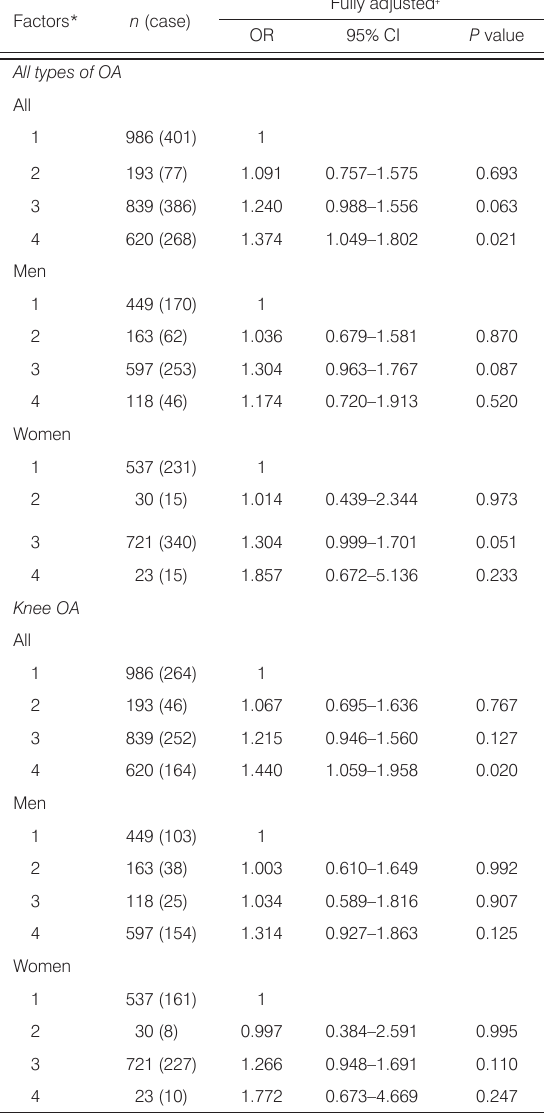
Table 2. Associations between smoking status and OA in Chinese adults aged 50 years or older. Notes: Logistic regression analysis. *1: nonsmokers; 2: active smokers, namely self- smokers; 3: passive smokers; 4: active and passive smokers. ‡ Adjusted for age, BMI, waistline, hipline, sex, education, occupation, home ventilation, heating, and alcohol consumption. OA=osteoarthritis; OR=odds ratio; CI=confidence interval; BMI=body mass